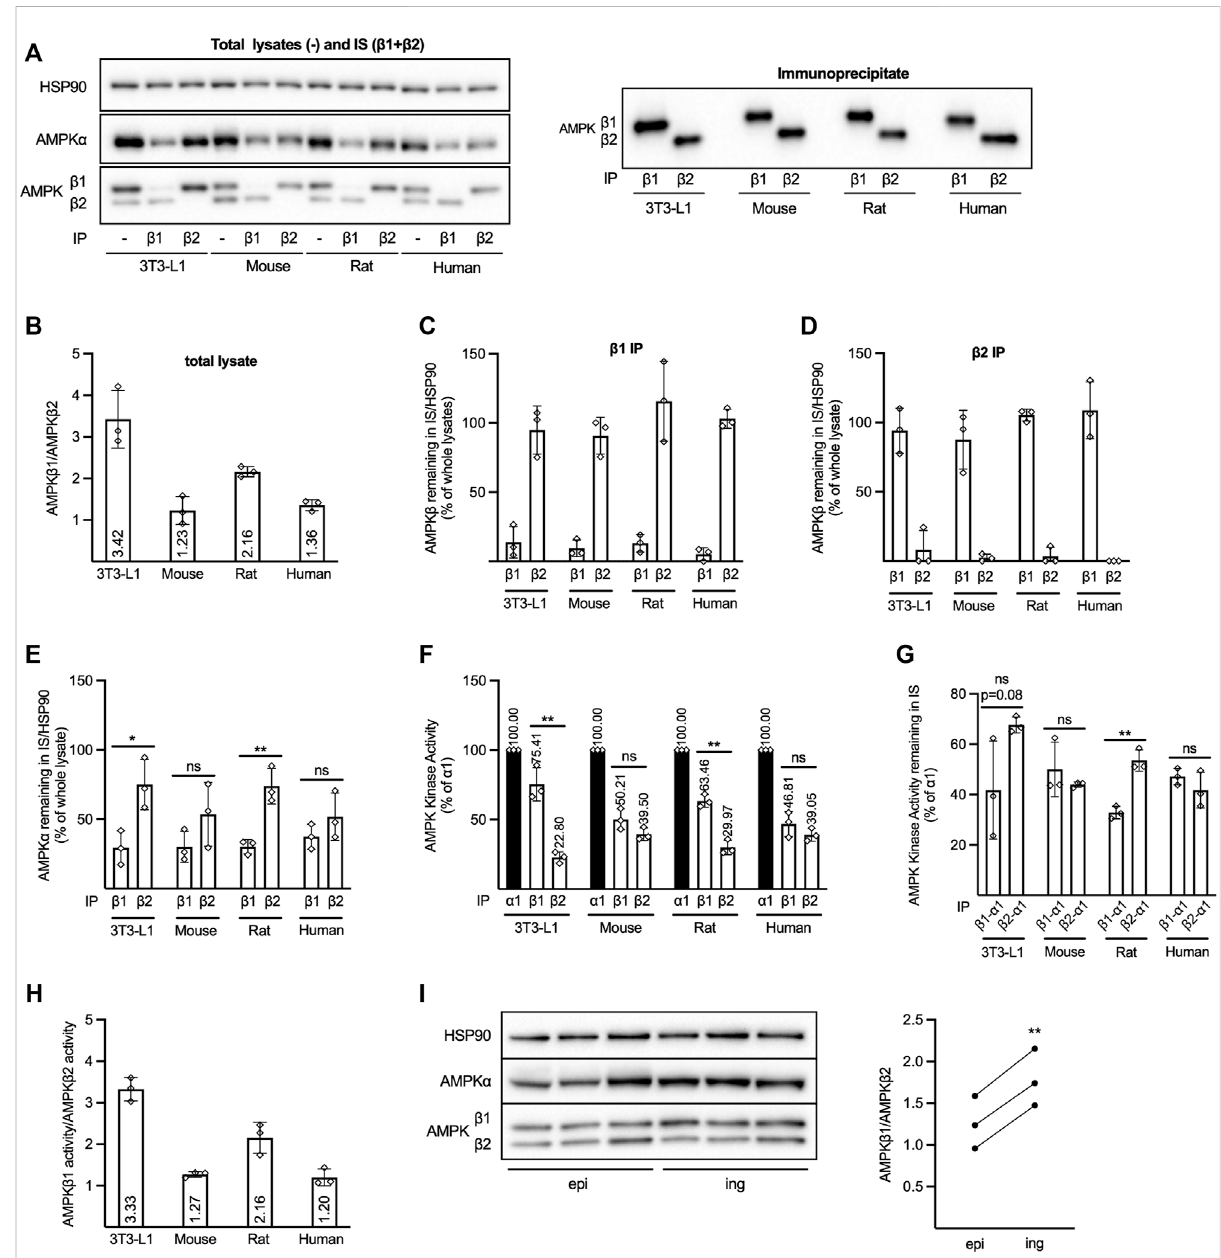
FIGURE 1 ExpressionofAMPK β isoformsindifferentadipocytemodels.Celllysateswerepreparedfrom3T3 – L1adipocytesoradipocytesisolatedfrommouseor rat epididymal- or human subcutaneous adipose tissue. (A – E) AMPK β 1 or β 2 was immunoprecipitated (IP) from lysates using isoform-speci fi c antibodies. Whole lysates ( = lysates prior to IP), IPs, and supernatants collected after IP (immuno-supernatants, IS), were analyzed by western Western blotting (A) . AMPK β 1and β 2signalsinwholelysates(B)orinimmuno-supernatants(IS)collectedafter β 1- (C) or β 2 (D) IPwerequanti fi edandexpressedas β 1/ β 2 (B) or%ofthecorrespondingsignalfromthewholelysate (C,D) . (E) Quanti fi edAMPK α signalsfromimmuno-supernatants(IS)collectedafter β 1-or β 2IPwere expressedas%ofAMPK α inthewholelysate. (F) AMPKinvitrokinaseactivitywasdeterminedafter α 1-(blackbar), β 1-(leftwhitebar)or β 2IP(rightwhitebar). (G) AMPK α 1invitrokinaseactivitywasdeterminedinimmuno-supernatants(IS)collectedafter β 1-or β 2IPinF. (F,G) Dataisexpressedas%ofAMPK α 1activity inthelysateandabsoluteactivity(mU/mg)isshowninSupplementaryFigureS1. (H) RatioofAMPK β 1and β 2-associatedinvitrokinaseactivitydeterminedin Supplementary Figure S1A. All data (A – H) is expressed as mean of three independent experiments ± SD. (I) AMPK β 1 and β 2 in lysates of adipocytes isolated from mouse epididymal (epi) and inguinal (ing) adipose tissue from the same mouse (n = 3) were analyzed by western blotting (left panel) and quanti fi ed signals were expressed as β 1/ β 2 (average epi = 1.26, average ing = 1.79; right panel). Statistical signi fi cance was determined by unpaired (E – G) or paired (I) , two-tailed, Students t-test * p 0.05, **pp 0.01, ns = non – signi fi